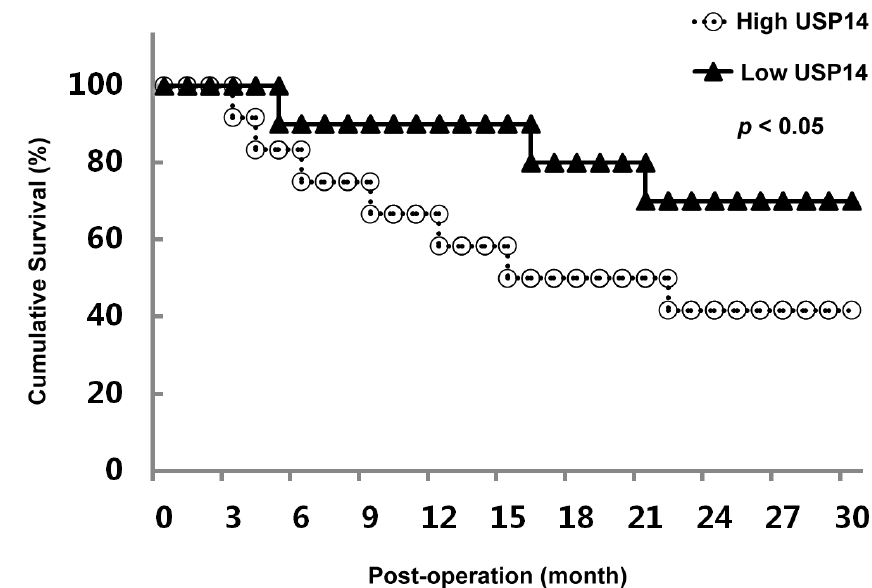
Figure 3. Kaplan-Meier plot of overall survival in lung adenocarcinoma patients post-operation according to the immunostaining results of